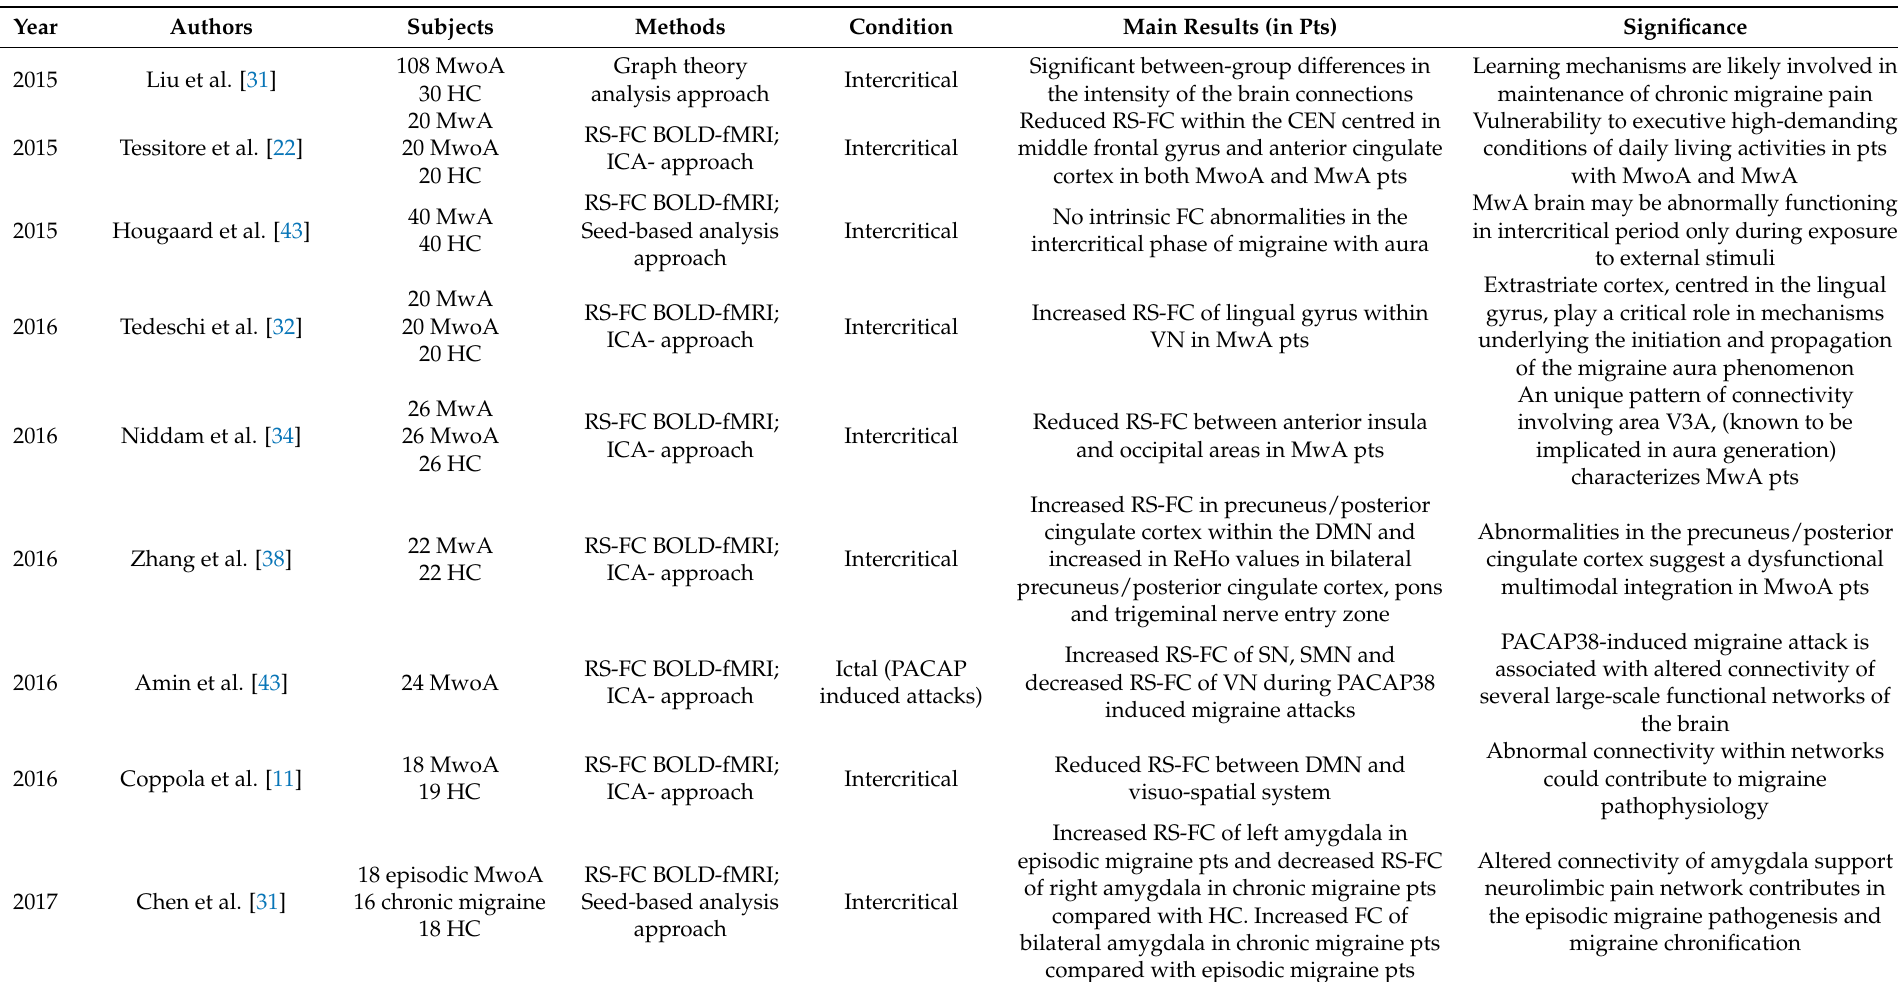
Table 1. Case Control Resting State Functional Connectivity